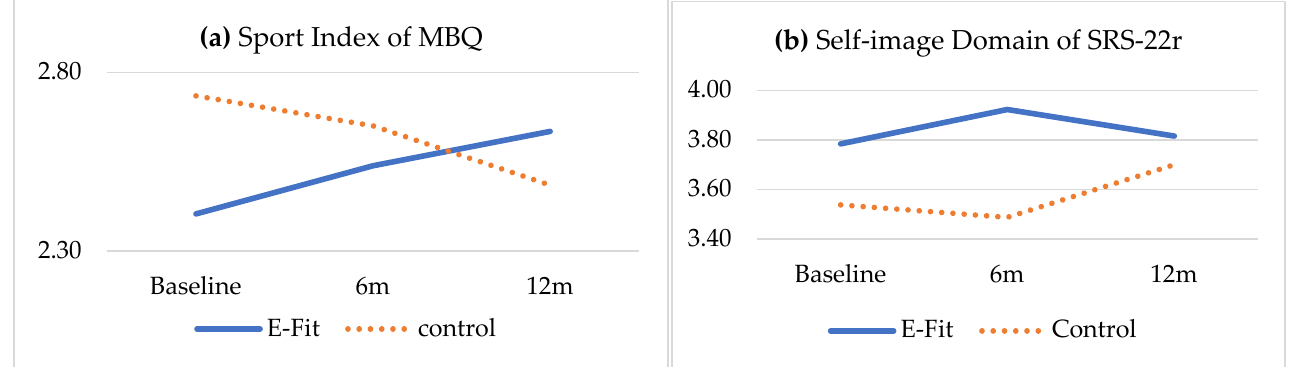
Figure 2. Changes of ( a ) sport index of MBQ and ( b ) self-image domain of SRS-22r across groups and time in the subjects.